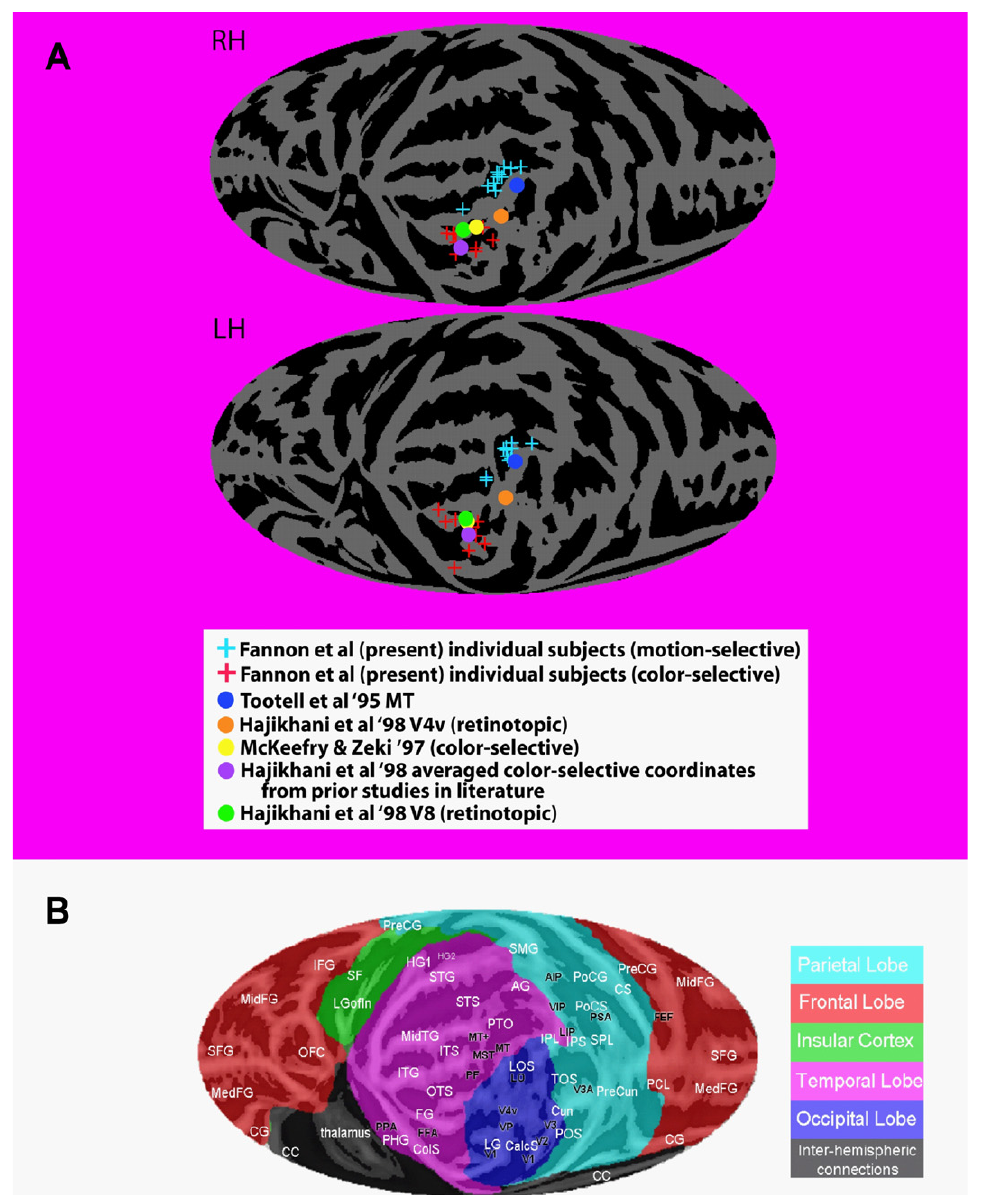
Figure 3. Mapping of individual loci of ROIs for motion and color compared to functional and retinotopic localizations in the literature. (A) Motion- sensitive (blue plus signs) and color-sensitive areas (red plus signs) for each subject were mapped onto a standardized average fl at map of the right (top) and left (bottom) hemisphere using local landmark-based methods derived from those of Kang et al. (2004) (see also www.ebire.org/hcnlab/cortical-mapping). The projection onto a plane uses a Mollweide equal area projection. In the same fl attened representations, the maxima for the group activations for the locations of MT, V4 and V8 as defi ned in prior studies using functional localizers and retinotopic mapping (colored circles – see key in fi gure). Note that the right hemisphere fl at map has been reversed around the vertical midline to permit comparison to the anatomical map key in “b”. (B) Flat map of the cortical surface showing major sulci and gyri labeled for comparison. Abbreviations of anatomical structures: AG, angular gyrus; CC, corpus callosum; CG, cingulate gyrus; CalcS, cal- carine sulcus; ColS, collateral sulcus; Cun, cuneate; CS, central sulcus; FG, fusiform gyrus; HG, Heschls gyrus; IFG, inferior frontal gyrus; IPL, inferior parietal lobule; IPS, intraparietal sulcus; ITG, inferior temporal gyrus; ITS, inferior temporal sulcus; LG, lingual gyrus; LGofi n, long gyrus of the insula; LOS, lateral occipital sulcus; MedFG, medial frontal gyrus; MidFG, mid-frontal gyrus; MidTG, middle temporal gyrus; OFC, orbitofrontal cortex; OTS, occipital temporal sulcus; PCL, paracentral lobule; PHG, parahippocampal gyrus; POS, parieto-occipital sulcus; PoCG, postcentral gyrus; PoCS, postcentral sulcus; PreCG, precentral gyrus; PreCun, precuneus; PTO, parietal/temporal/occipital point; SF, Sylvian fi ssure; SFG, superior frontal gyrus; SMG, supramarginal gyrus; SPL, superior parietal lobule; STG, superior temporal gyrus; STS, superior temporal sulcus; TOS, transverse occipital